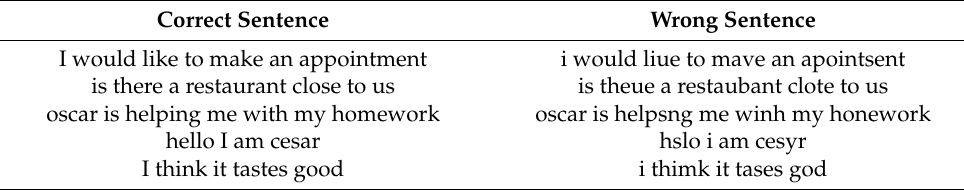
Table 3. Recurrent Neural Network (RNN) training dataset sample.